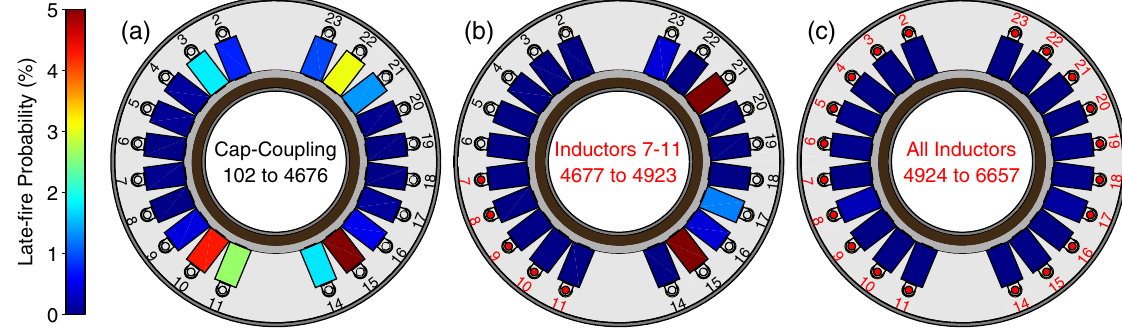
FIG. 12. Distribution of late-fire events in the 100-GW LTD cavity. Each plot shows the probability (in percent) of a late-fire at each of the 20 bricks in the cavity over a particular range of shots and trigger circuit configuration. The left plot (a) is late-fires from shots where all bricks used capacitive trigger coupling. The center plot (b) is a range of shots where bricks seven through 11 used inductive trigger isolation, all others remained capacitively coupled. The right plot (c) is late-fires from shot 4924 to present where all bricks use the inductively isolated trigger